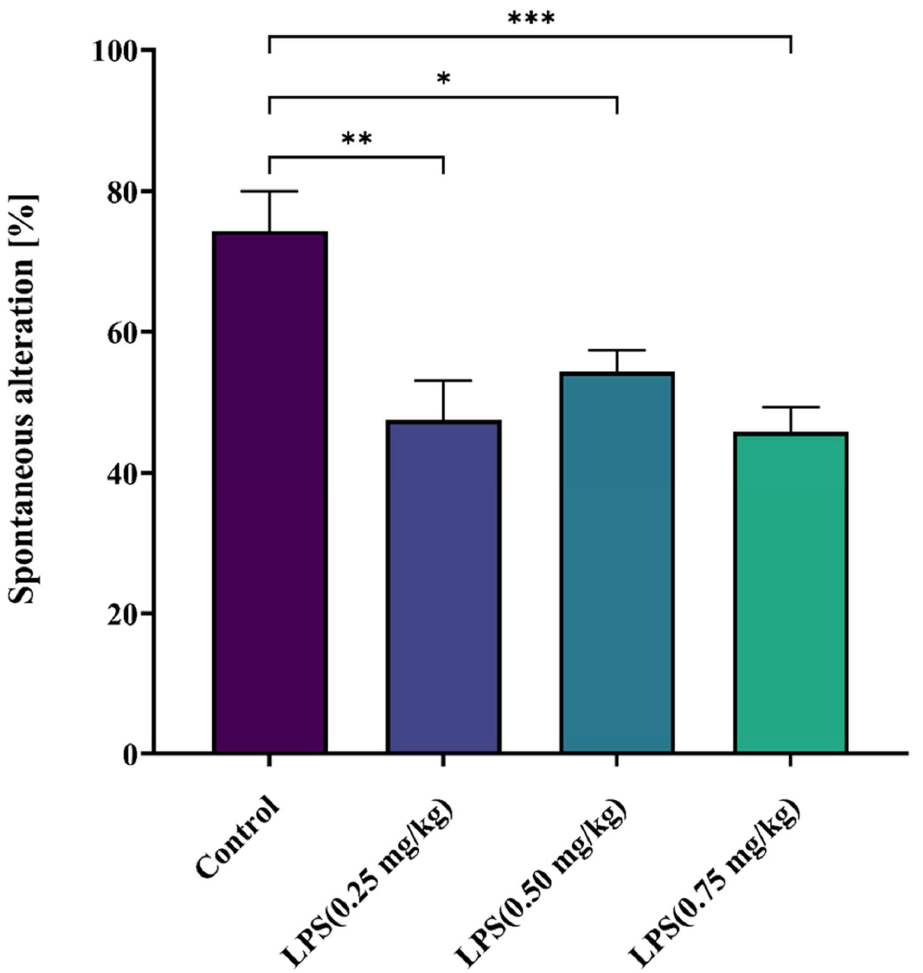
Figure 4. Y maze. Significant differences in spontaneous alternation were observed in all LPS groups (0.25 mg/kg, 0.50 mg/kg, and 0.75 mg/kg) compared with the control group. Data are presented